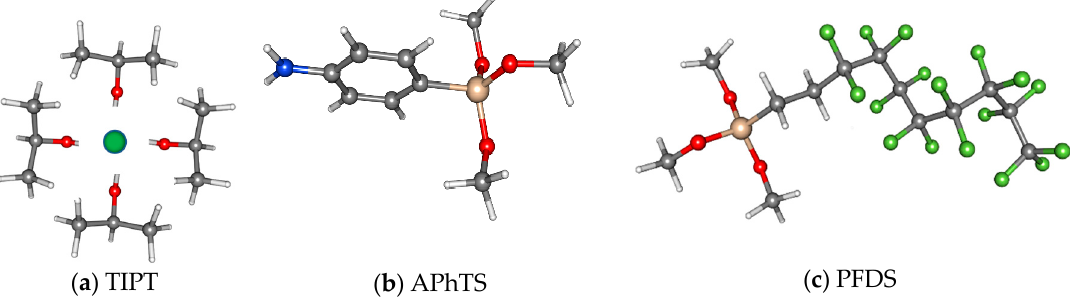
Figure 2. Molecular structure of titanium–isopropoxide (TIPT) ( a ) aminophenyl-trimethoxy-silane (APhTS) ( b ) and perfluorodecyl-trimethoxy-silane (PFDS) ( c ) (courtesy of PubChem).